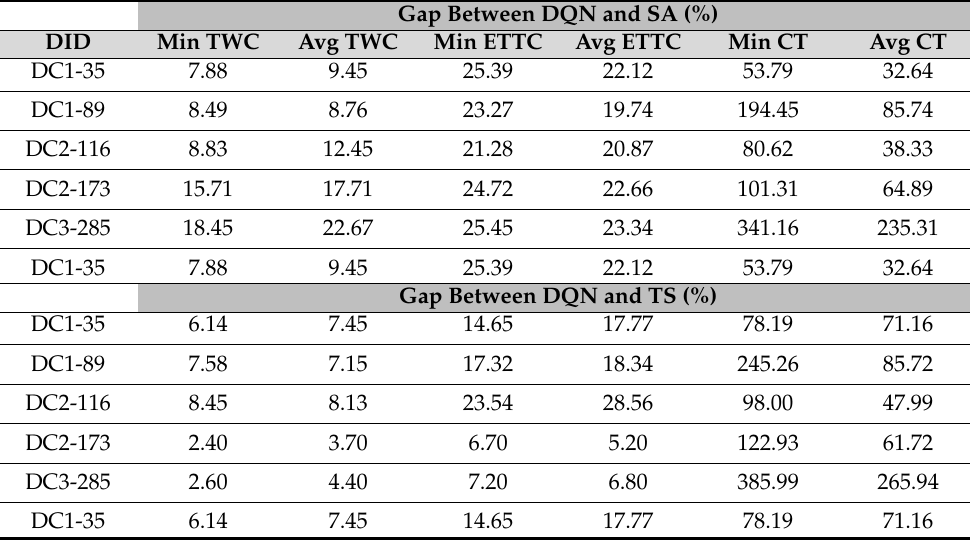
Table 11. Performance gaps between DQN and SA and between DQN and